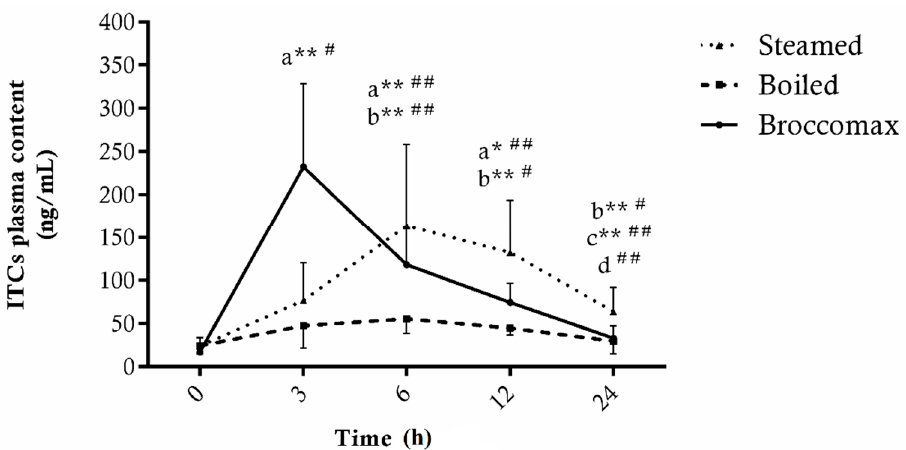
Figure 4. Total isothiocyanates (ITCs) levels in plasma of 7 subjects before (0) and after 3, 6, 12 and 24 h consumption of supplement (BroccoMax ® ) and broccoli cooked with boiling or steaming treatment. Data are expressed as ng/mL of plasma ± SD of three technical replicates. * p < 0.05 and ** p < 0.01 vs. 0 h (a), 3 h (b) and 6 h (c) in subjects supplemented with BroccoMax ® ; # p < 0.05 and ## p < 0.01 vs. 0 h (a), 3 h (b), 6 h (c) and 12 h (d) in subjects supplemented with steamed